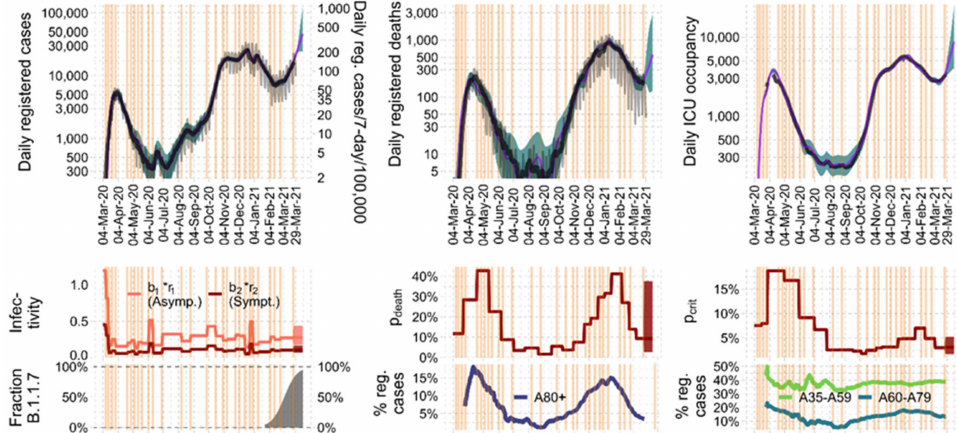
Figure 2. Agreement of model and incident data. We show incident infections, deaths, and daily ICU occupancy during the course of the epidemic in Germany in between 4 March 2020 and 29 March 2021. Comparison of IO-NLDS model (magenta curve) and data (thin grey curves = raw data, solid black curve = data averaged by sliding window) is provided in the upper column. A good agreement is observed (shaded area = prediction uncertainty, vertical lines = changes in NPI/contact behavior). The middle row represents the corresponding input layer, i.e., the estimated time course of the time-dependent input parameters, namely infectivity and probabilities of critical disease course and death. Time steps correspond to the lines of changing NPI/contact behavior as displayed in the upper row. In the lower row, we present percentages of B.1.1.7 among infected subjects (first figure), subjects older than 80 years among infected corresponding to high death tolls (second), and subjects in the age categories 35–59, respectively 60–79 among critical cases (last figure of last